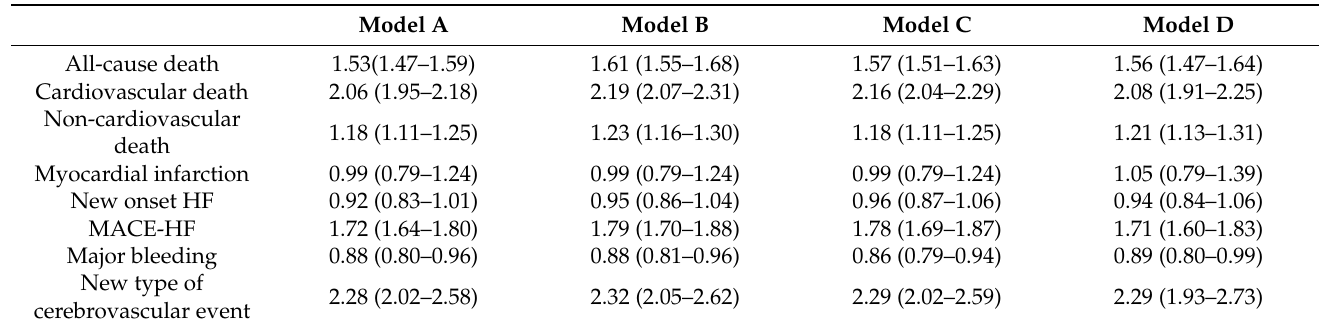
Table 4. Hazard ratio ratios (95% CI) associated with incident outcomes in non-traumatic intracranial hemorrhage with AF (versus ischemic stroke survivors).